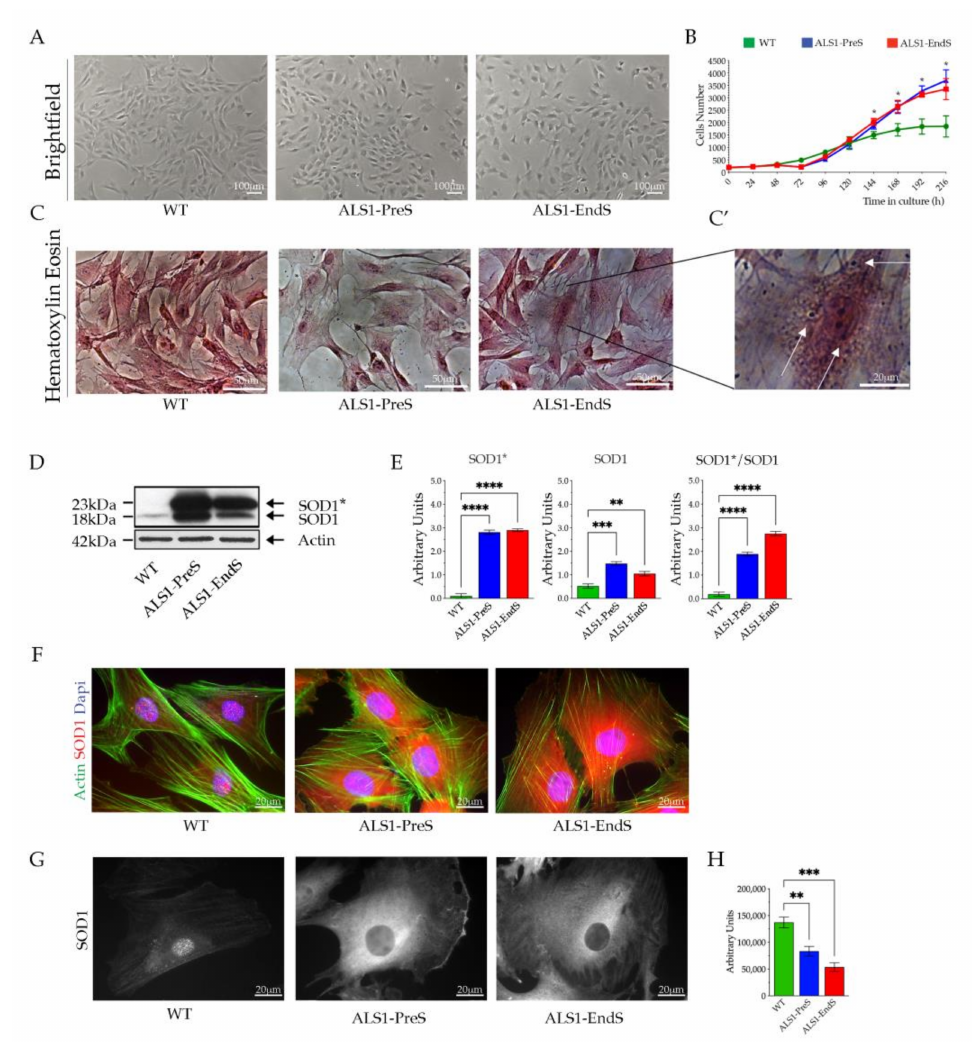
Figure 2. Expression of SOD1* in rFFFs. ( A ) Representative brightfield images of WT, ALS1-PreS, and ALS1-EndS fibroblasts. Scale bar = 100 mm. ( B ) Growth curve of diseased and WT rFFFs. Each point represents the mean of three technical replicates; * p < 0.05. ( C ) Representative images of Hematoxylin/Eosin (Scale bar = 50 mm) and ( C’ ) high magnification of the ALS1- EndS cells. Scale bar = 20 mm. ( D ) Representative Western blotting analysis of naïve SOD1 and human mutant SOD1* in ALS1 and WT rFFFs. ( E ) Densitometric analysis of the SOD1*, SOD1, and SOD1*/SOD1 ratio. Results are reported as mean ±